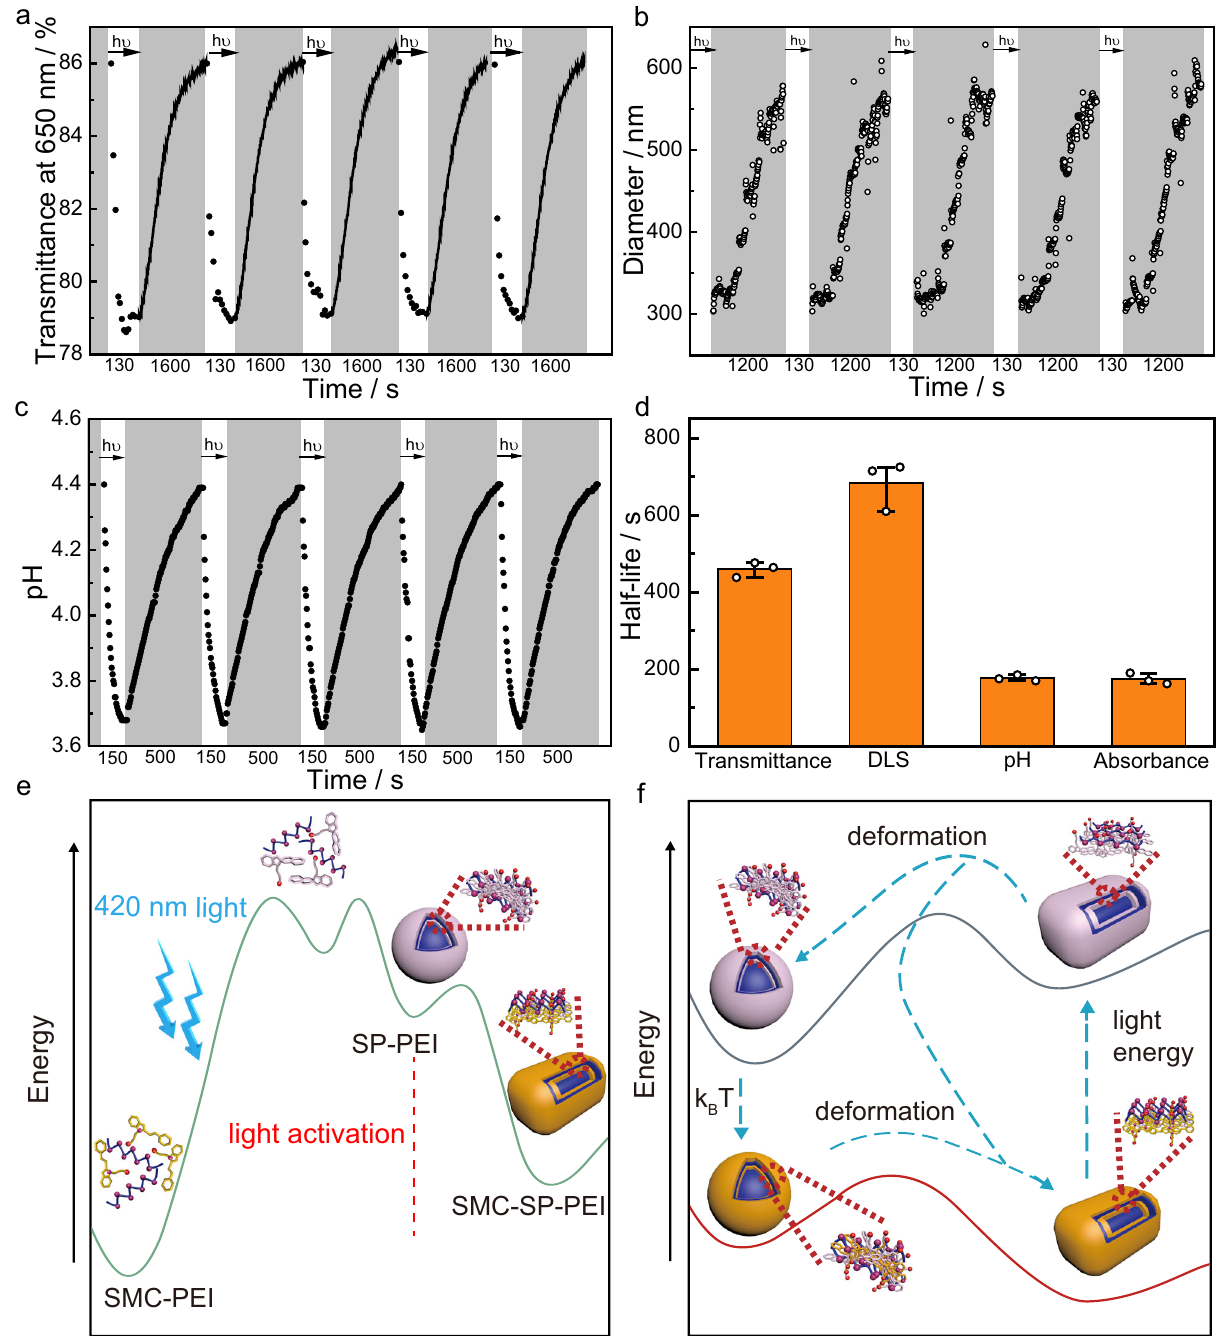
Fig. 4 Dissipative properties of the photodeformable supramolecular DSAs. a Optical transmittance at 650 nm for 5 cycles between the SMC-PEI and SP-PEI dissipative process over time. The white areas represent the light-induced formation of SP-PEI nanoparticles and the gray areas represents the formation of SMC-SP-PEI nanoparticles, respectively. b Diameter variation during thermal deformation process from the SP-PEI to SMC-SP-PEI for 5 cycles over time measured by DLS. c pH variation for 5 cycles between the SMC-SP-PEI and SP-PEI dissipative process over time. The white parts represent the light-induced formation of SP-PEI and the gray parts represents the formation of SMC-SP-PEI nanoparticles, respectively. d Half-lives of the thermal deformation process from SP-PEI to SMC-SP-PEI exhibited by the transmittance at 650 nm, DLS, pH and absorbance at 424nm. n = 3 independent experiments, with the bar data indicating mean ± SD ([SMC] initial = 0.225 mM, [PEI] = 5 μ g mL − 1 ). e Schematic representation of the energy variation of the light-activation process for the photodeformable DSAs. f Schematic representation of the energy variation in the photodeformable dissipative process of SP-PEI and